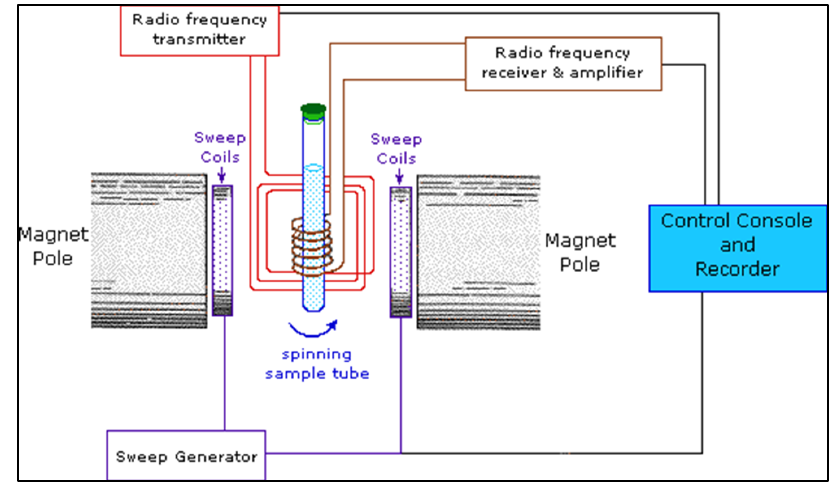
Figure 25. Components of NMR instrument [122].